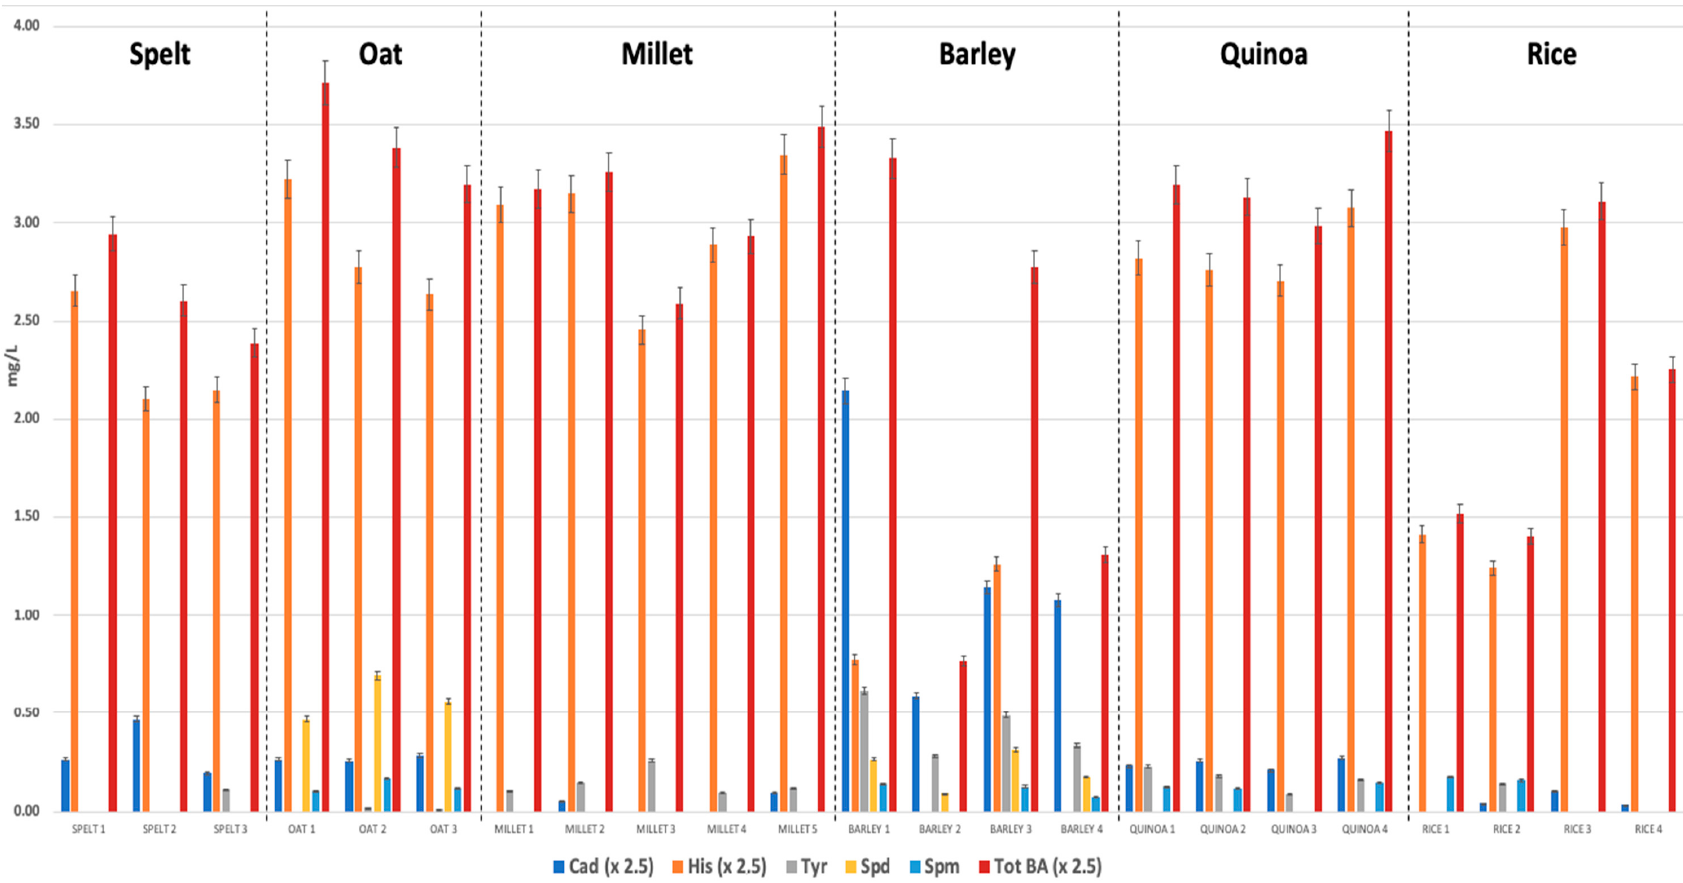
Figure 3. Biogenic amine concentration (mg / L) and total biogenic amine content.